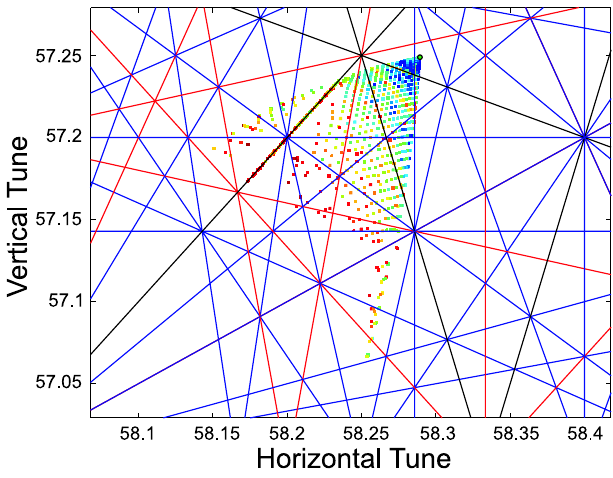
FIG. 12. (Color) Footprint on the tune space, for the mode with momentum compaction 2 (cid:1) 10 (cid:2) 4 .